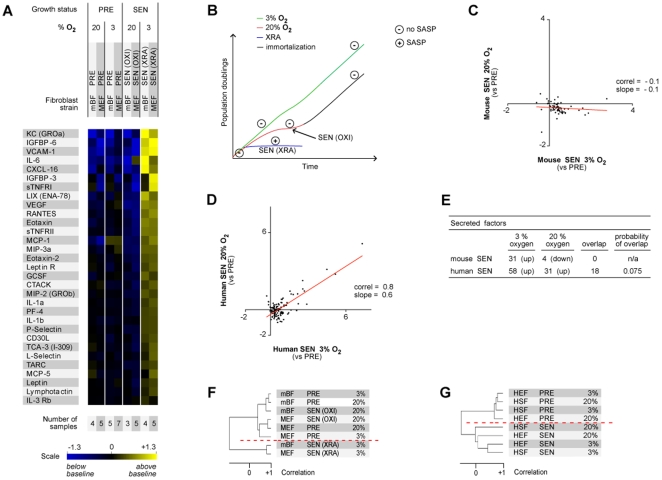
Secretory profiles of presenescent and senescent mouse fibroblasts.A) Soluble factors secreted by the indicted cells were detected by antibody arrays and analyzed as described [15]. For each cell strain, PRE and SEN signals were averaged and used as the baseline (average of PRE 3%, PRE 20%, SEN (XRA) 3%, SEN (OXI) 20%). Signals above baseline are shown in yellow; signals below baseline are in blue. The heat map key indicates log2-fold changes from baseline (changes greater than the scale show as saturated colors). The number of samples analyzed is shown below each lane (see also Dataset S1). B) Model of mouse cell proliferation in culture showing conditions under which SASPs do (+) and do not (−) develop. C–D) Correlation between the secretory profiles of mouse (C) or human (D) cells cultured and induced to senesce in 3% vs 20% O2. Baselines for the senescent profiles are the corresponding PRE profiles of cells cultured in the same O2 concentration. E) Comparisons of the number of secreted factors that change in human and mouse cells induced to senesce in 20% or 3% O2. F–G) Unsupervised hierarchical clustering analysis of PRE and SEN mouse (F) or human (G) fibroblasts (see also Fig. S1).